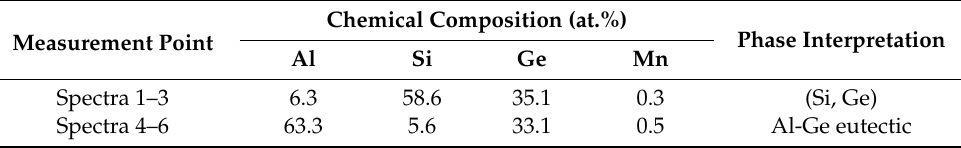
Figure 4. Microstructure of AA 6082 wetted with Al-40.0Ge-3.4Si wt.% filler alloy according to 540 ◦ C/10 min mode with EDX measurement points. Results of EDX analysis of the AA 6082/Al-40.0Ge-3.4Si wt.% filler according to 540 ◦ C/10 min mode alloy wetting